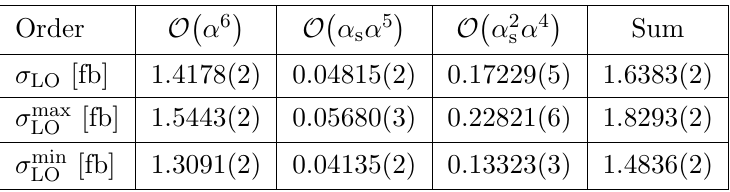
Table 2. Fiducial cross section at LO for the process pp orders